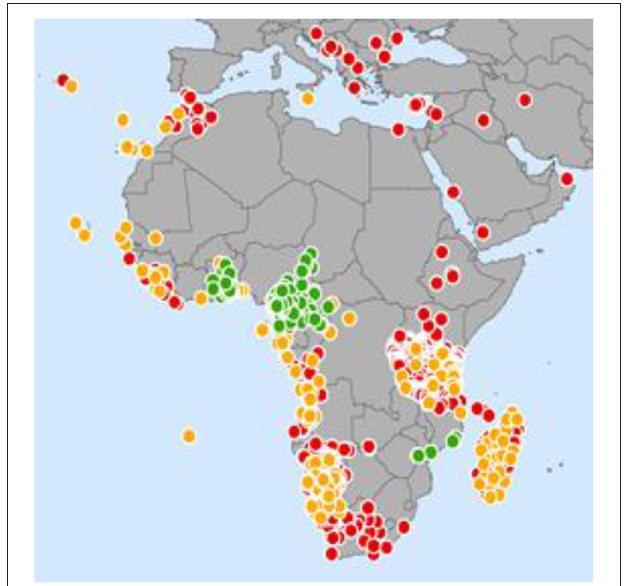
FIGURE 3 | Station location and status of digitization effort for historical stations in the archive of DWD. Colors indicated the status as of 8/2021: Green, digitized and quality controlled; yellow, in progress; red, not yet digitized.